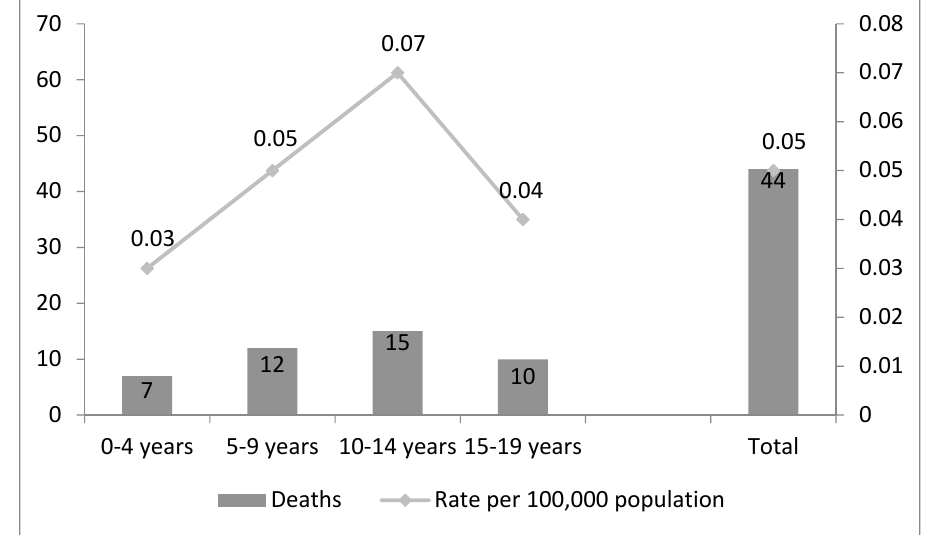
Figure 1. Crude annualized incidence and rate of child and adolescent flood-related fatal unintentional drowning by age group, Australia, 2002/03–2017/18 (N = 44). More females than males were involved in flood-related drowning among the 0–4 years age group (57.1% female), while in all other age groups, males were represented more highly than females, with double the number of male drownings when compared to females in the 10–14 years age group (66.7% male) and four times the number of drowning deaths among males in the 15–19 years age group (80.0% male) (Table 1).